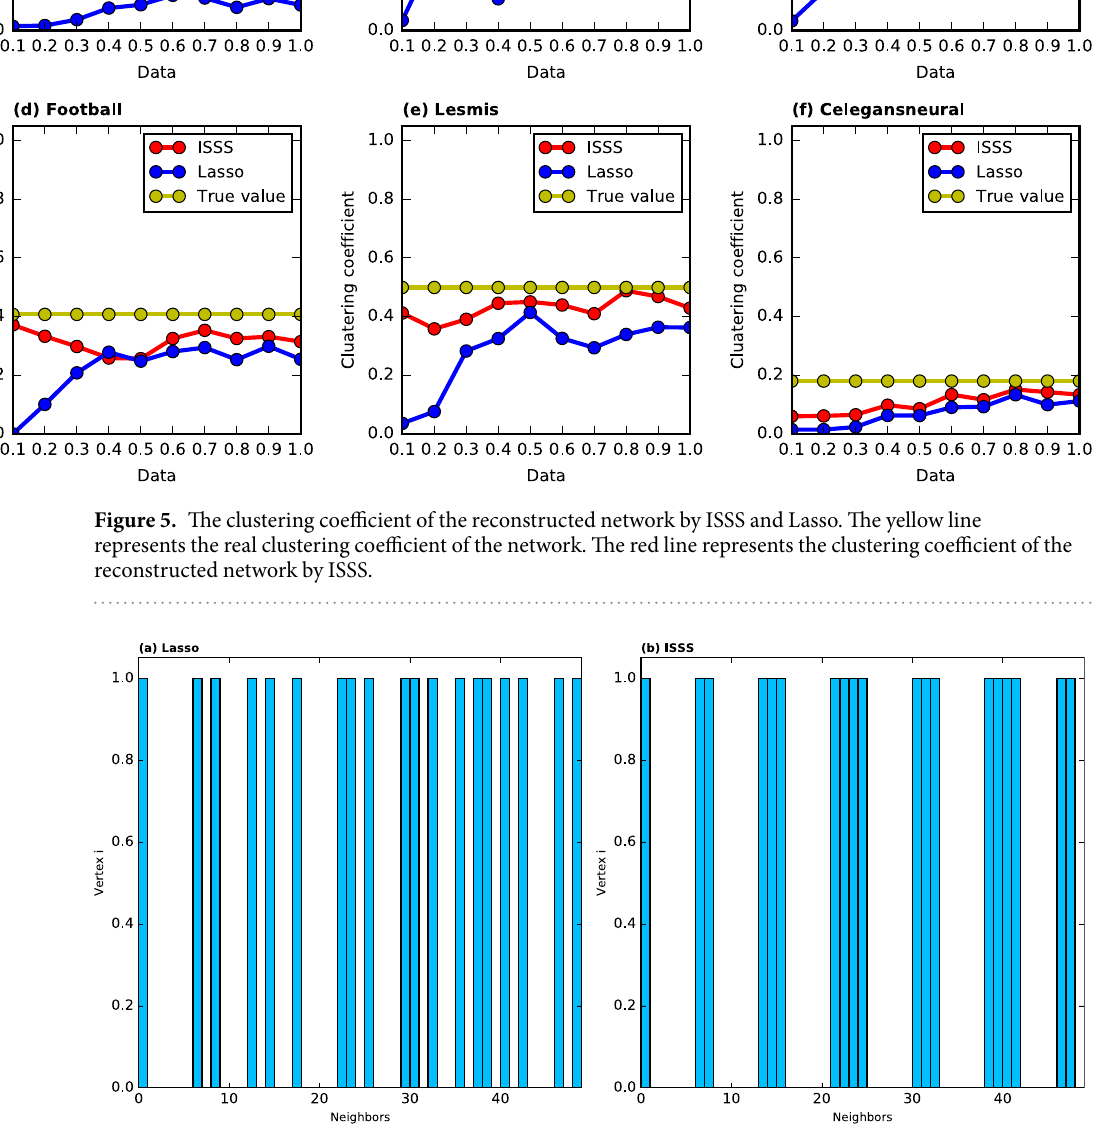
Figure 6. The reconstruction of vertex i ’s neighbors. Suppose there are 50 vertices in all. If vertex i is connected with vertex j , the corresponding item in histogram is 1, otherwise it is 0. Lasso is good at predicting the neighbors in a discrete style, while the ISSS is inclined to predict continuous neighbors. The continuous neighbors are probably the way to construct the community structure of the